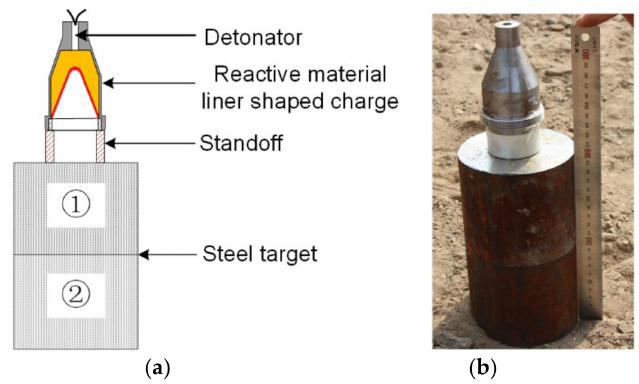
Figure 6. Schematic and photograph of the experimental setup: ( a ) schematic; ( b ) setup.